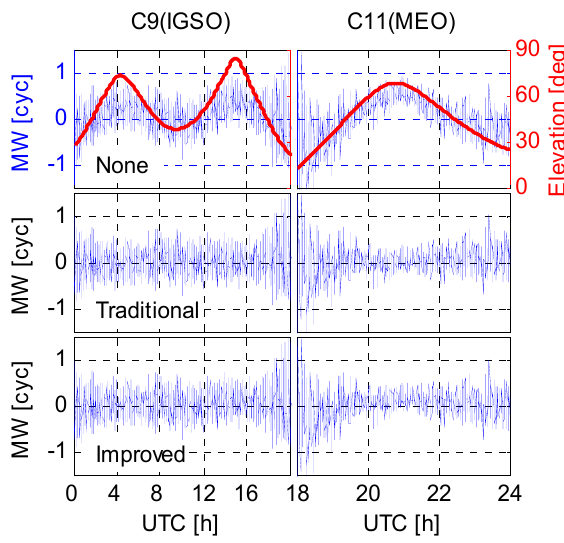
Sensors 2016 , 16 , 909 Figure 12. Time series of the derived MW value on XMIS (DoY 130/2015).